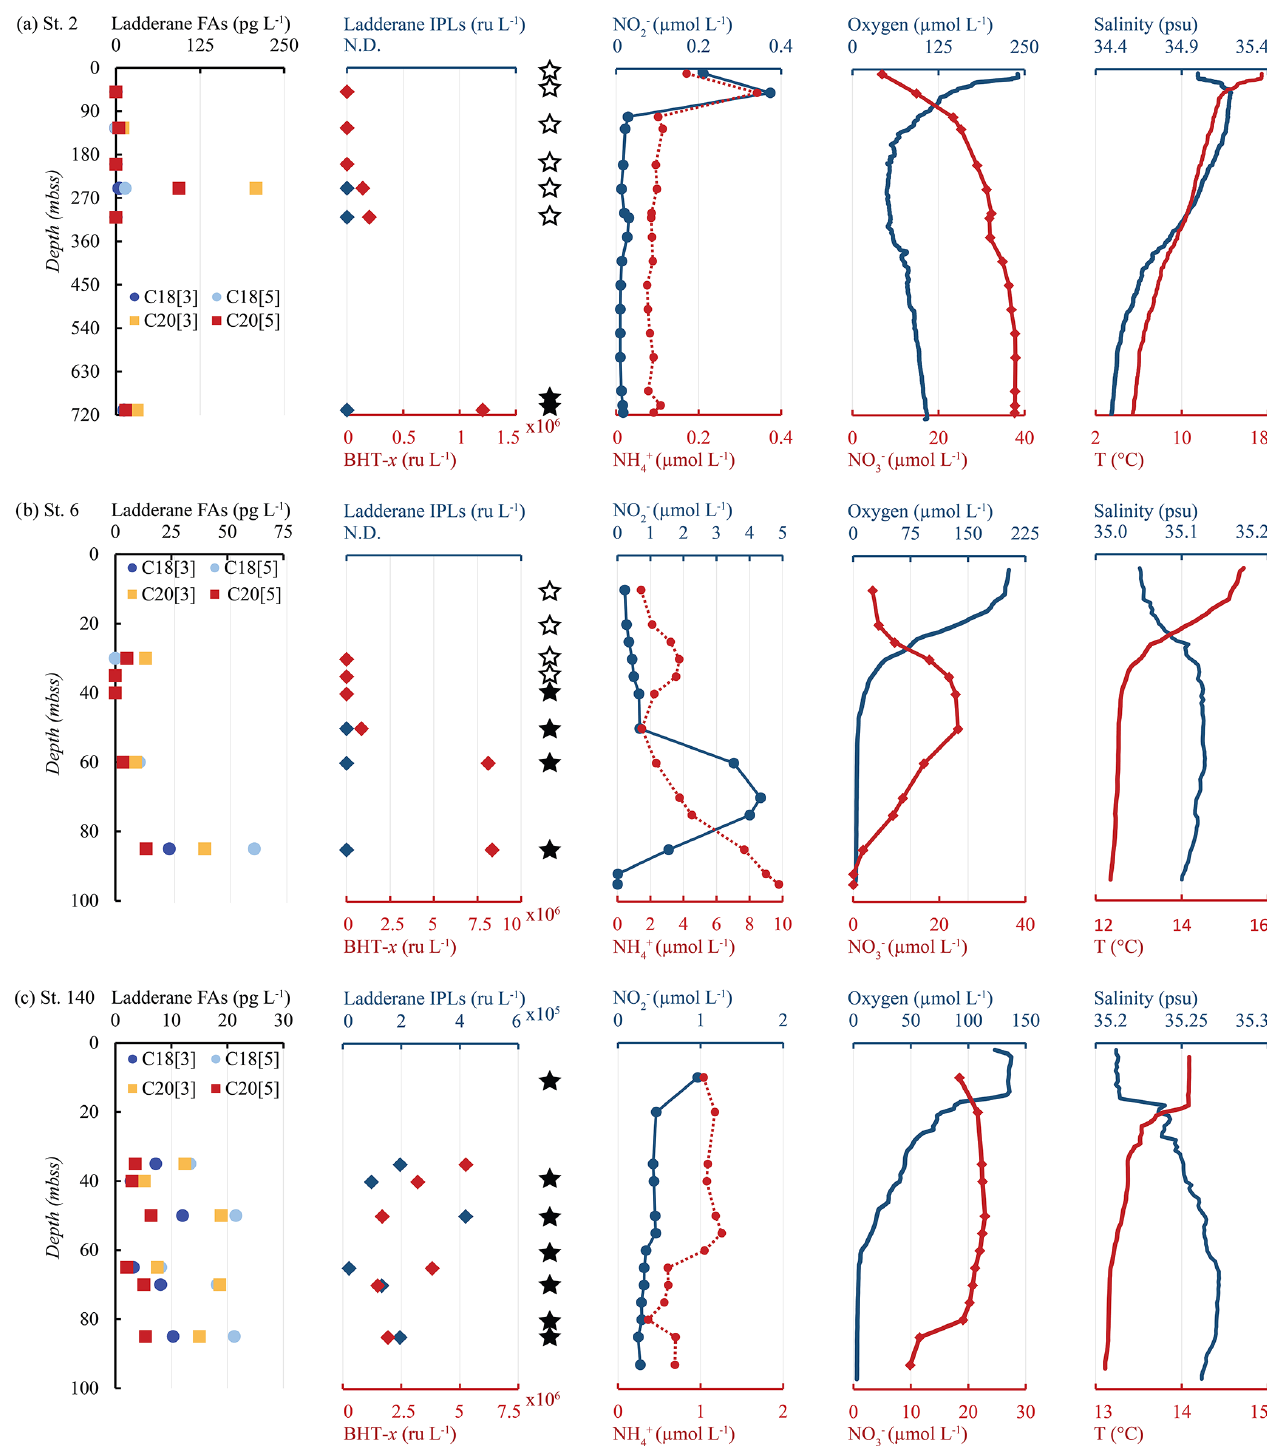
Figure 7. Water column depth profiles of stations (a) 2, (b) 6 and (c) 140, showing distributions of (from left to right) ladderane FAs (pgL − 1 ), ladderane IPLs and BHT- x (ruL − 1 ), nitrite and ammonium concentrations (µmolL − 1 ), oxygen and nitrate concentrations (µmolL − 1 ), and temperature ( ◦ C) and salinity (psu). Star symbols indicate water column depths where SPM was collected for DNA analysis. Filled stars represent depths where Ca. Scalindua spp. 16S rRNA gene sequences were detected. Stations 6 and 140 were sampled at the same location 27d apart (station 6 in February and station 140 in